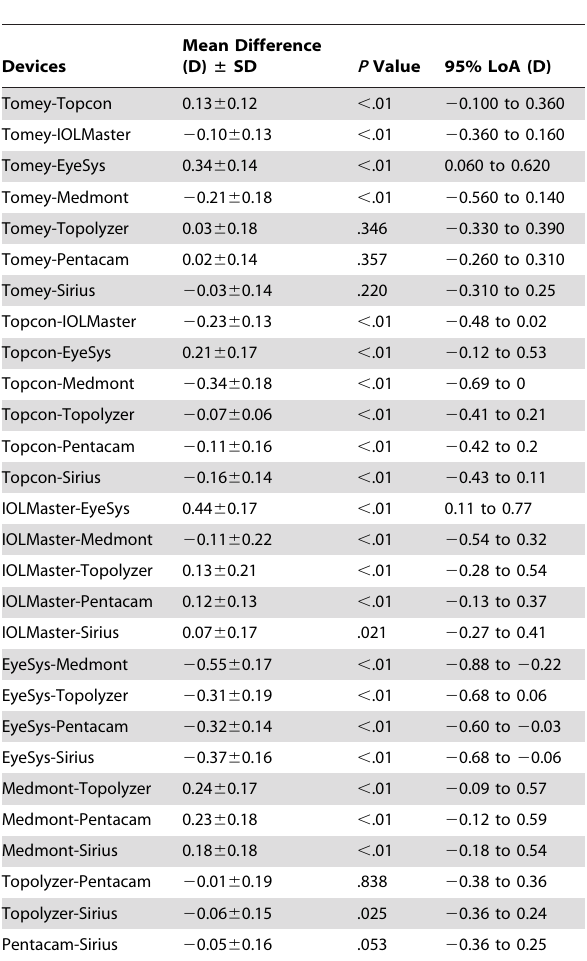
Table 5. Comparison of the Steep Keratometry between 8 Different Devices.